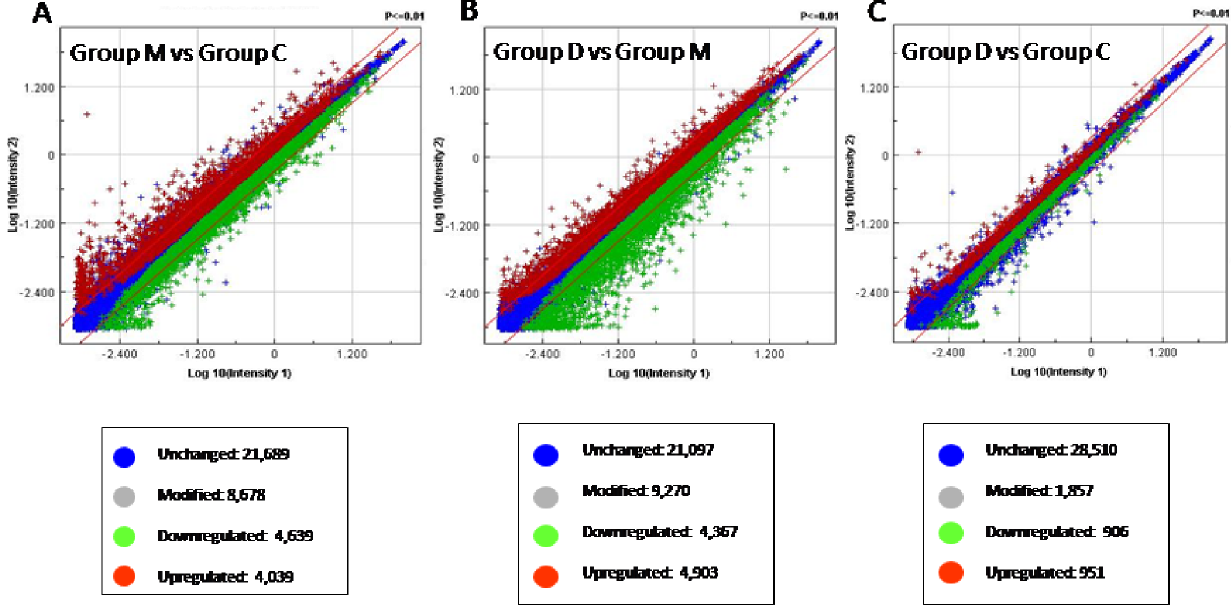
Figure 2. VSL # 3 reverses the NMS-induced alteration of gene expression: global microarray analysis. (A) Expression of 8,678 (28.57% of total) genes was globally modified in NMS animals compared with normal rats (Group M vs Group C): 4,039 (13.29%) were upregulated and 4,639 (15.27%) were downregulated. (B) VSL # 3 effectively resected gene expression in NMS rats (Group D vs Group M): 9,270 (30.5% of total) genes were globally modified, 4,903 (16.14 of total%) were upregulated, while 4,367 (14.38% of total) were downregulated. (C) VSL # 3 administration to NMS rats caused a pattern of gene expression that was similar to that of control rats (Group D vs Group C). Microarray data from 3–4 replicates.